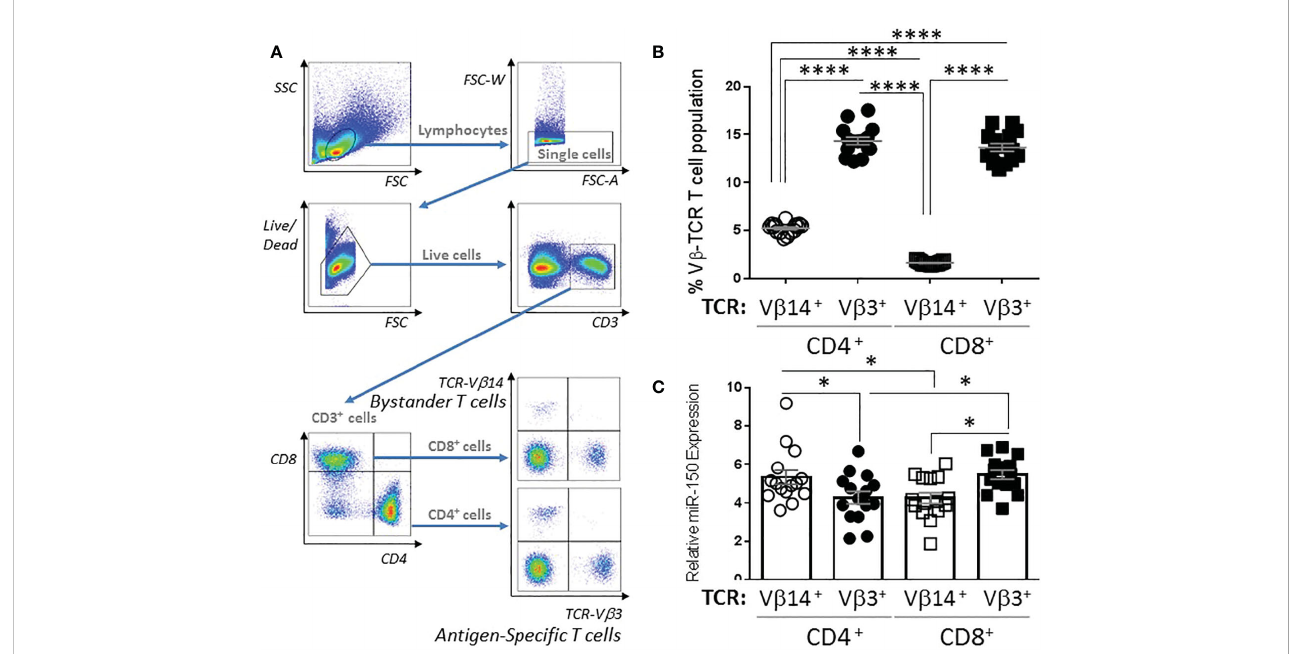
FIGURE 1 miR-150 expression is differentially regulated in CD4 + and CD8 + T cells. (A) Gating strategy of splenocytes from C57BL/6 mice 48 h post S. aureus enterotoxin A (SEA) injection. Cells were gated as lymphocytes based on FSC/SSC, single, live, CD3 + , CD4 + or CD8 + , and TCR-V b 3 + or TCR-V b 14 + . (B) T cells were analyzed as described in A and reported as percent of the total CD4 + or CD8 + population (top panel). Data were combined from 2 independent experiments. Each dot represents a mouse, n=15/group. (C) T cells described in B were sorted to purity ~ 95-98%, RNA was obtained and miR-150 expression was reported for each cell population. Each dot represents a mouse, n=15/group +/- s.e.m. Statistical signi fi cance was evaluated by 2-way ANOVA. (ns: non-signi fi cant, (*p < 0.05; ****p <